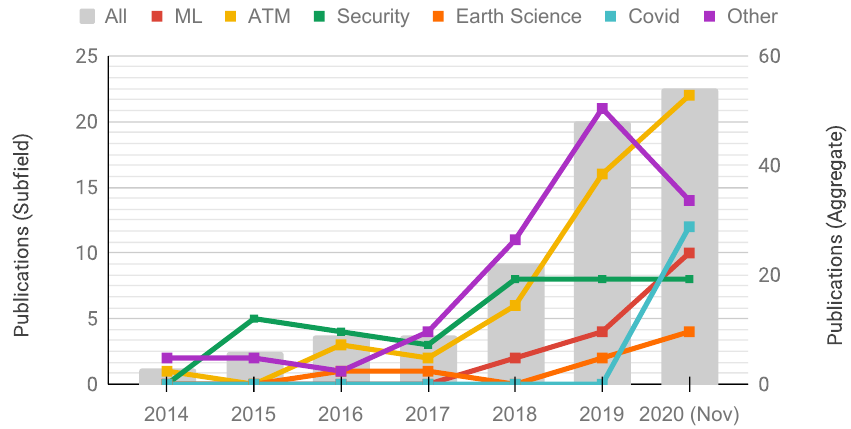
Figure 2. Publications with OpenSky data from 2014 to November 2020. Overall numbers as bars on the right vertical axis. Subfield numbers as lines on the left vertical axis. Publications may have multiple fields.